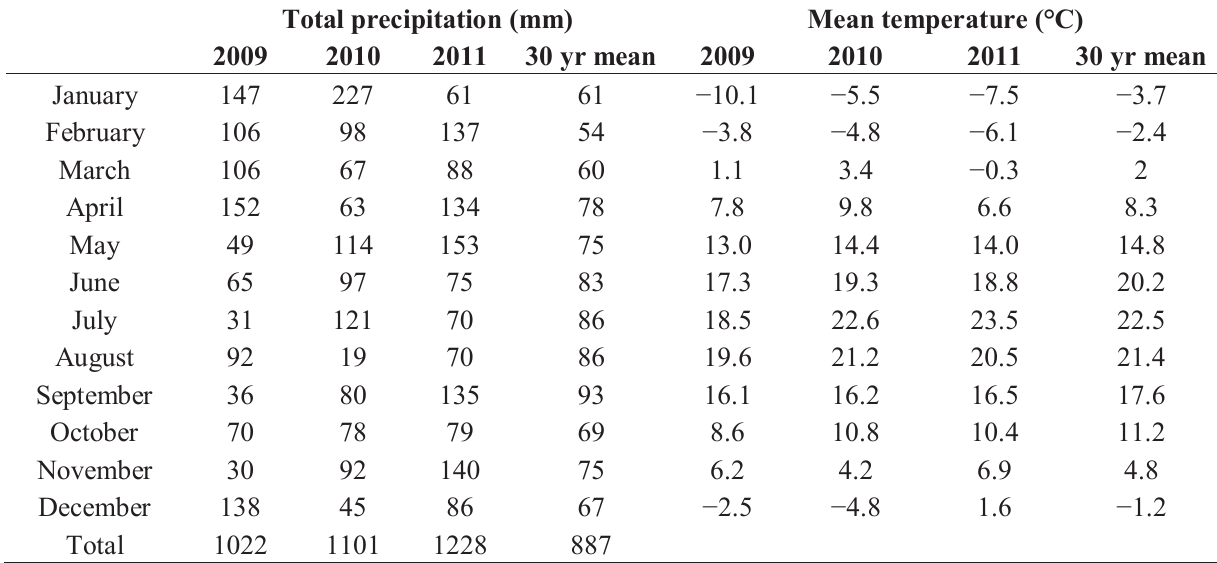
Table 2. Monthly total precipitation and mean temperature and the 30-yr mean at Ridgetown, ON, Canada, during